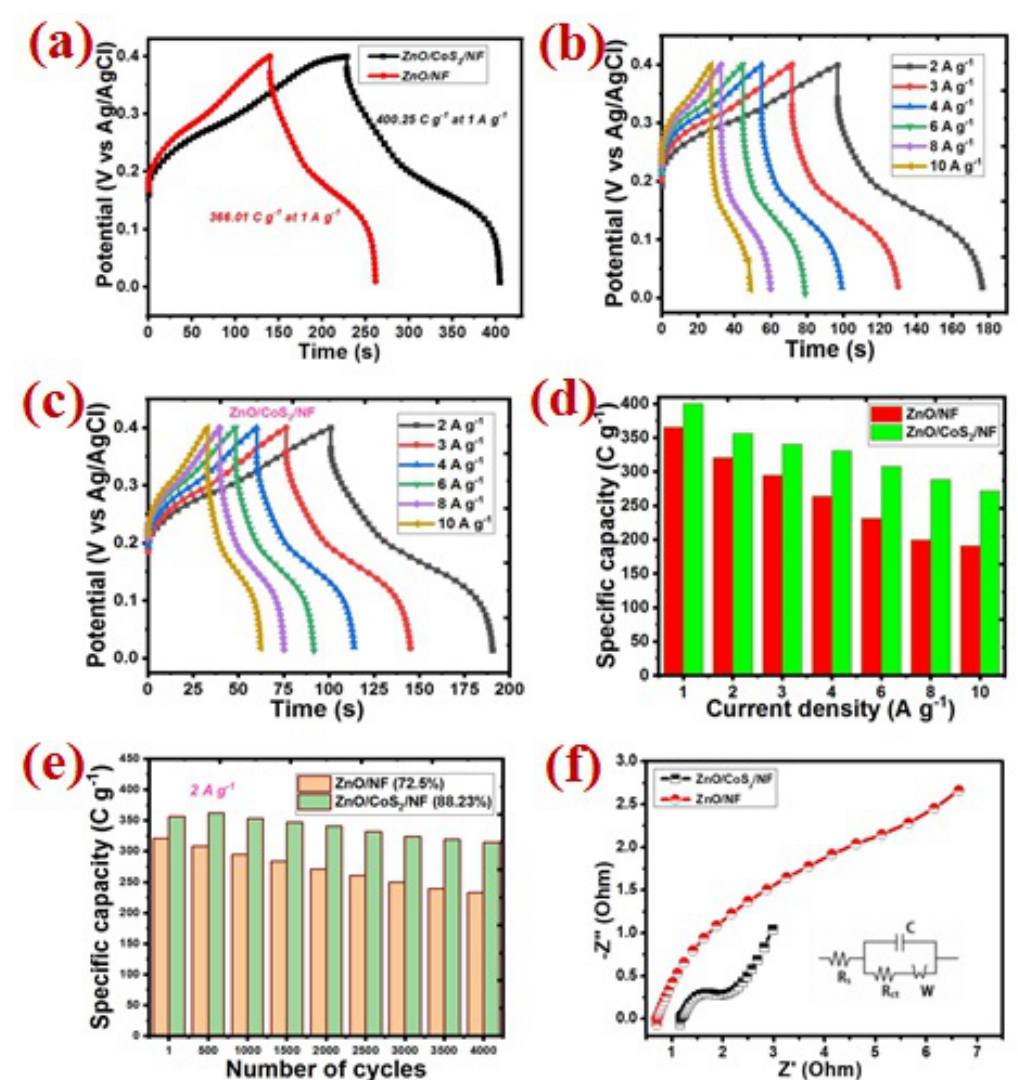
Figure 5. ( a ) Charge–discharge curves of ZnO/NF and ZnO/CoS 2 /NF nanocomposites at 1 A·g −1 ; charge–discharge plots of ( b ) ZnO/NF and ( c ) ZnO/CoS 2 /NF at various current densities. ( d ) Specific capacity of the prepared electrodes as a function of the current density. ( e ) Long-term cycling stability of the ZnO/NF and ZnO/CoS 2 /NF at 2 A·g −1 for 4000 GCD cycles. ( f ) EIS curves.